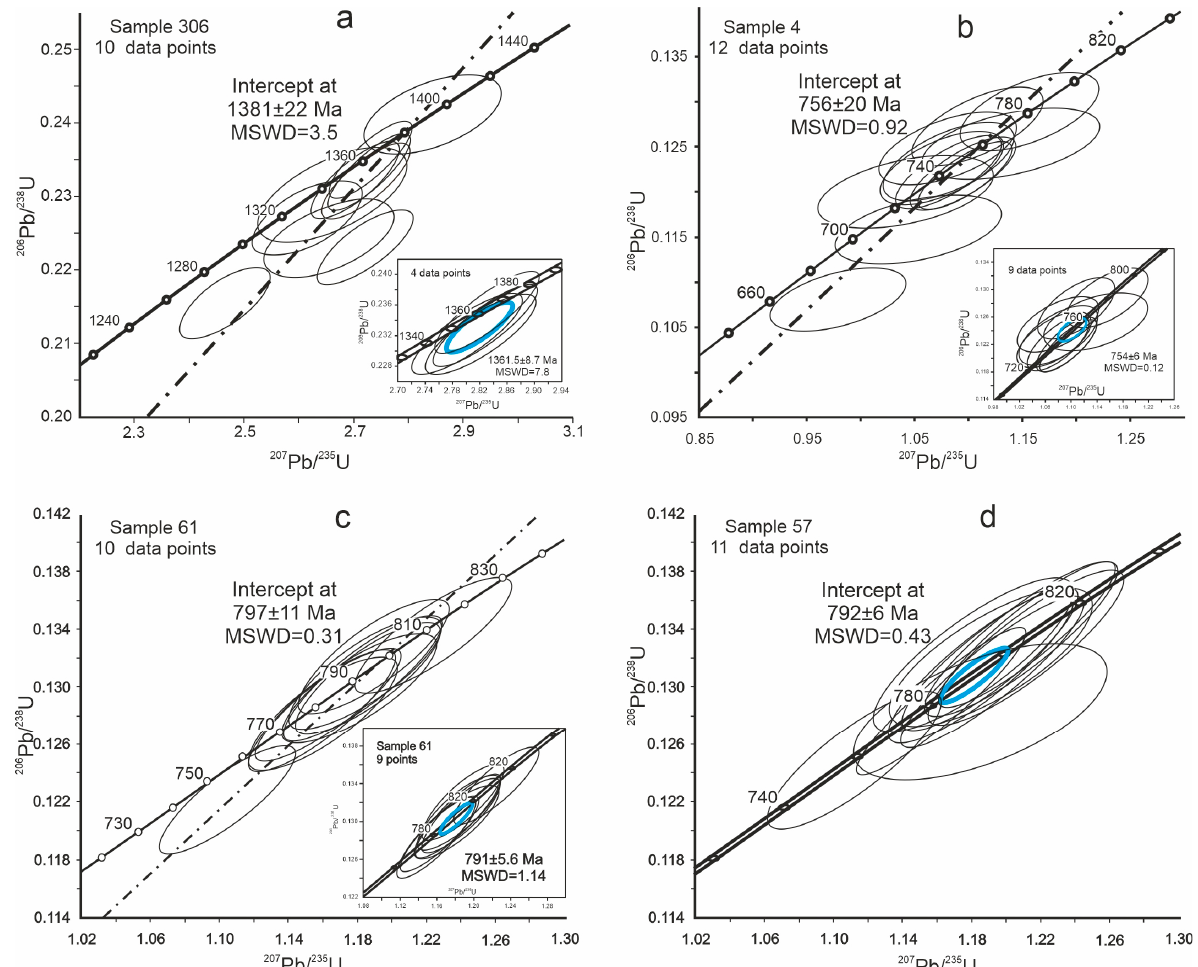
Figure 23. Concordia diagram for zircons ( a ) from the plagiogneiss granite collected from the Nemtikha Group, ( b ) from granites of the Ostrovok Island, and ( c , d ) from granite dykes of the bimodal dyke belt. Blue ellipse—average age values.